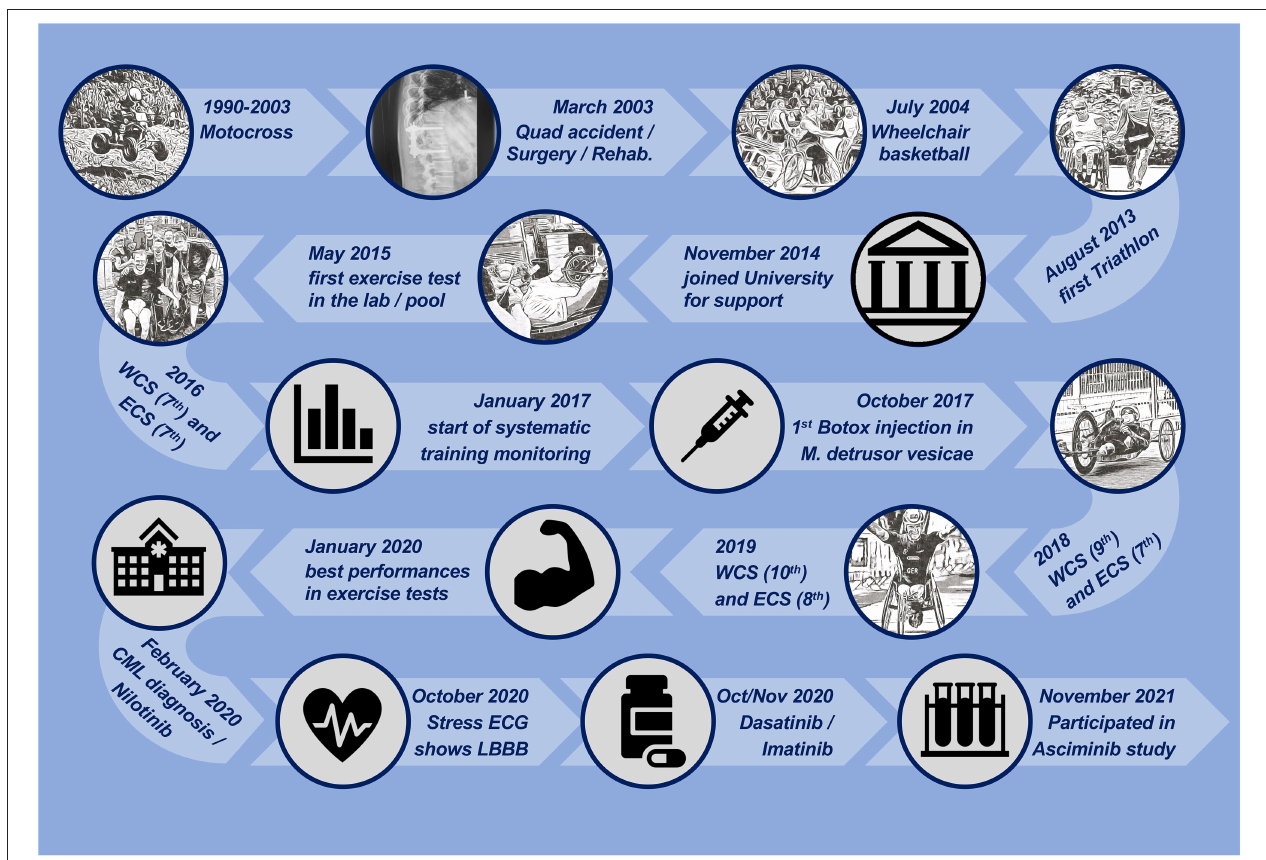
FIGURE 1 | Timeline of the athlete’s personal history and milestones during the exposure. CML, chronic myeloid leukemia; ECG, electrocardiogram; ECS, european championship; SCI, spinal cord injury; LBBB, left bundle branch block; WCS, world